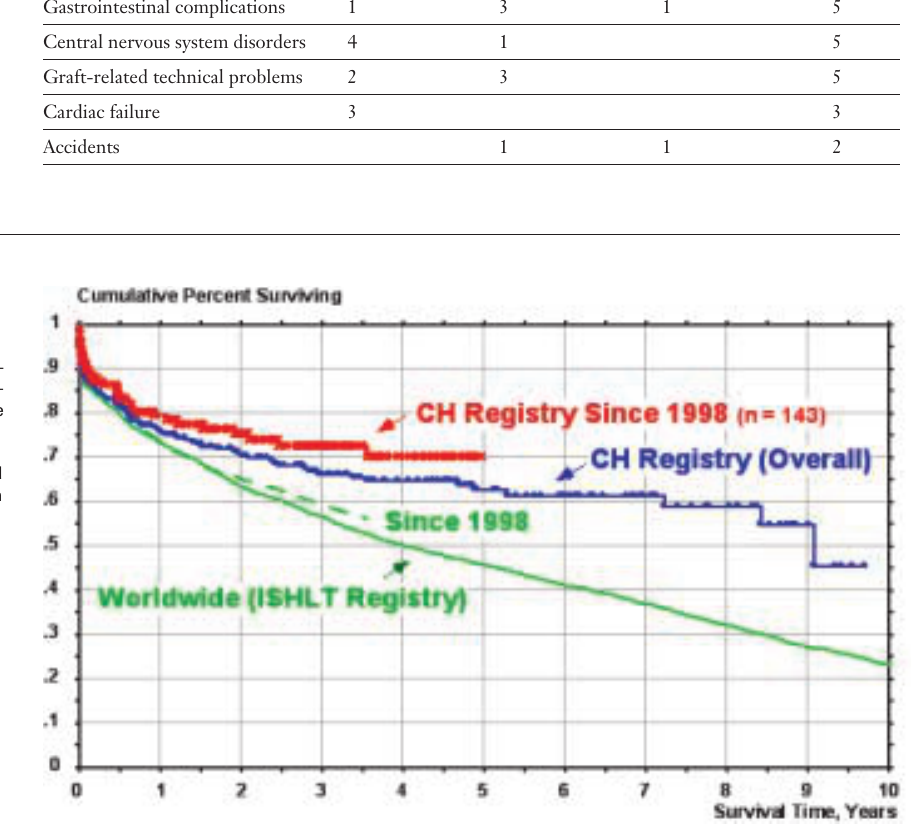
Causes of death in 80 lung transplant